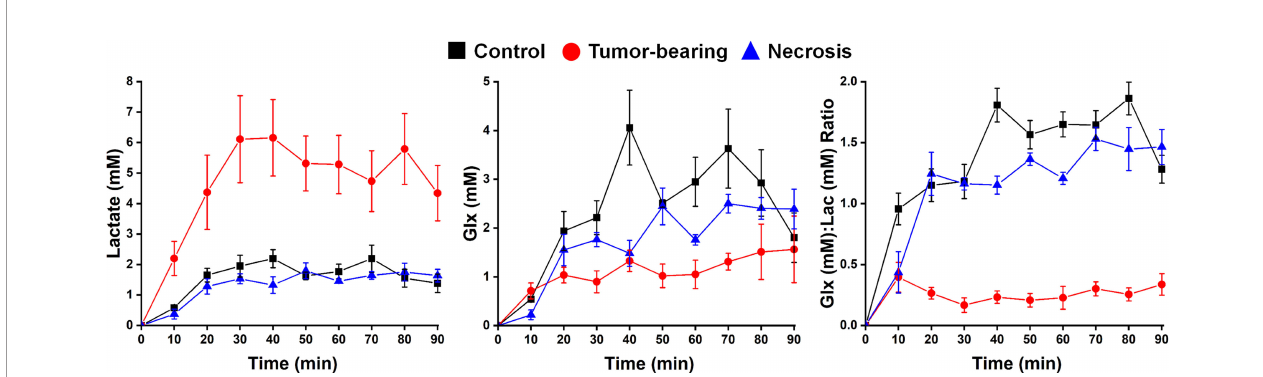
FIGURE 9 | Time-course plots (means ± SEM) for the concentration of (left) Lac and (middle) Glx, and (right) the concentration ratio Glx : Lac derived from a 90-min series of 10-min acquisition spectra with n = 4 mice each condition (control, tumor-bearing, radiation necrosis). These time-course spectroscopy data were analyzed using two-way ANOVA for repeated measurement, followed by post-hoc comparison of the least squares means (LSM) across groups. ANOVA2/LSM results are — Lac: tumor vs. necrosis, p <0.0001; tumor vs. control, p <0.0001; necrosis vs. control, p = 0.7631; Glx: tumor vs. necrosis, p = 0.0671; tumor vs. control, p = 0.0004; necrosis vs. control, p = 0.0685; Glx/Lac: tumor vs. necrosis, p <0.0001; tumor vs. control, p <0.0001; necrosis vs. control, p